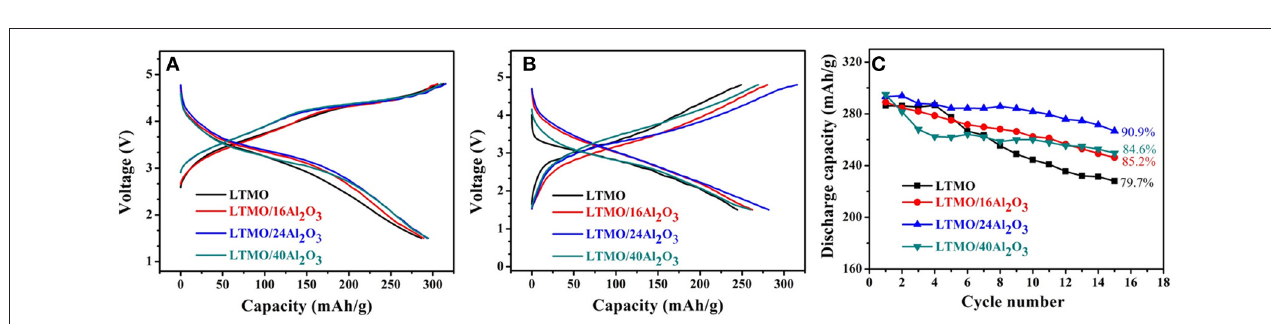
FIGURE 5 | (A) Initial charge-discharge curves; (B) 10th charge-discharge curves; (C) cyclic performance of the pristine LTMO and Al 2 O 3 -coated LTMO electrodes.